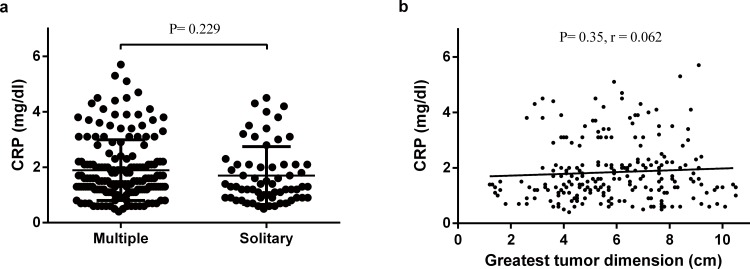
The correlation between CRP and different clinicopathological features groups.(a) Distribution of CRP in both multiple tumors group and solitary tumor group. No significant difference of CRP level was found between the two groups (P = 0.229). (b) The correlation between preoperative serum CRP and the maximal tumor dimensions. This scatter plot showed that preoperative serum CRP levels were not positive correlation with the maximal tumor dimensions (P = 0.35, r = 0.062).